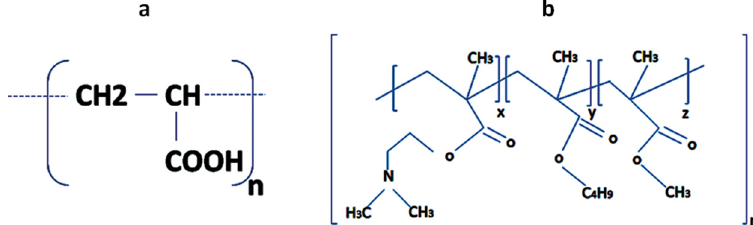
Figure 5. ( a ) Chemical structure of polyacrylic acid (PAA); ( b ) Chemical structure of Eudragit